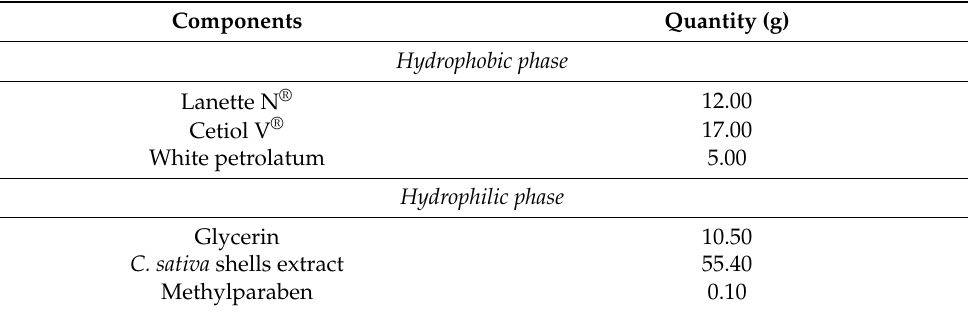
Table 2. Composition of the O/W formulation containing C. sativa shell